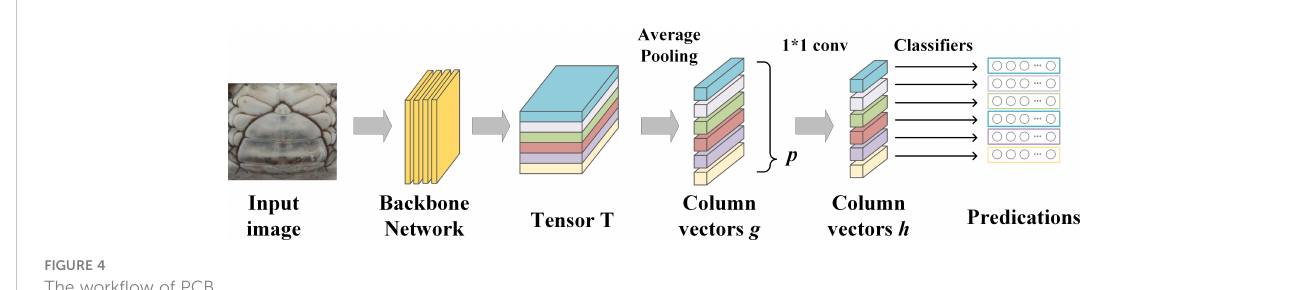
FIGURE 4 The work fl ow of